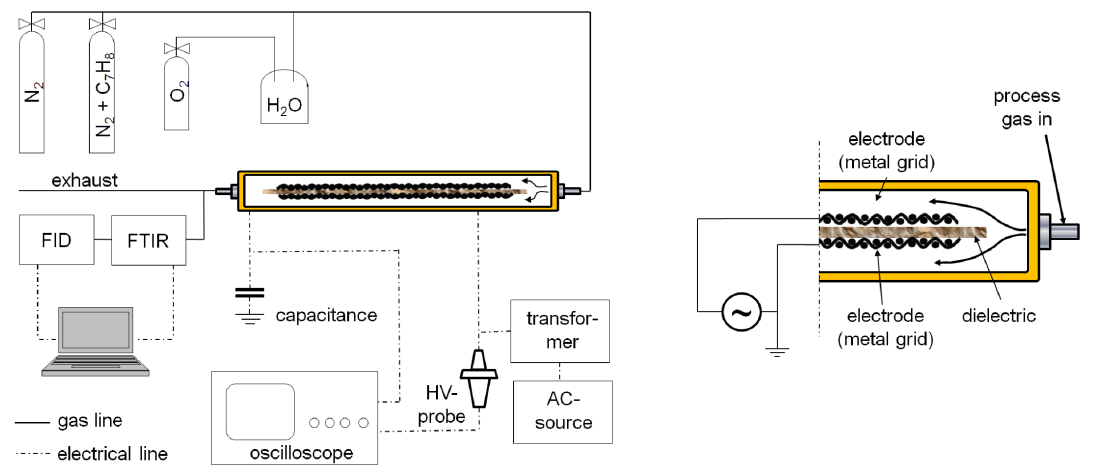
Figure 1: Experimental Setup (left) and detailed horizontal cut view of reactor (right).